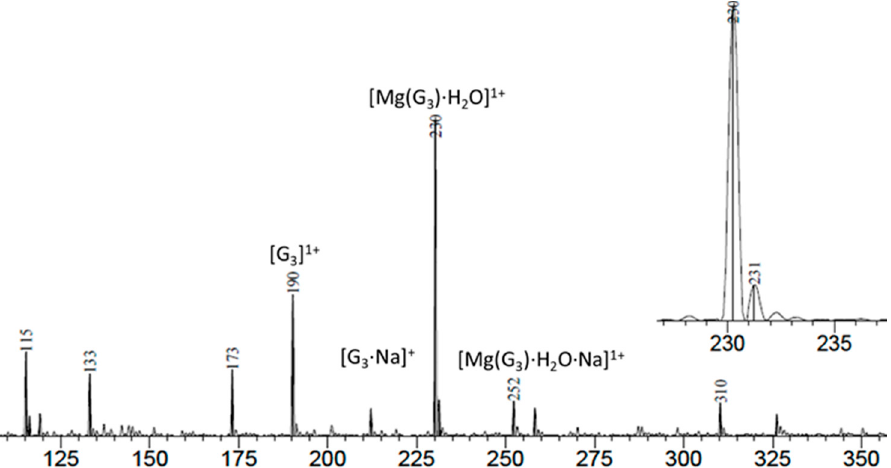
Figure 1. ESI-MS of MgG 3 indicating the presence of both the free HG 3 ligand as well as the chelate HG 3 ligand. Inset at right exhibits the appropriate isotopic distribution pattern of a magnesium chelate.